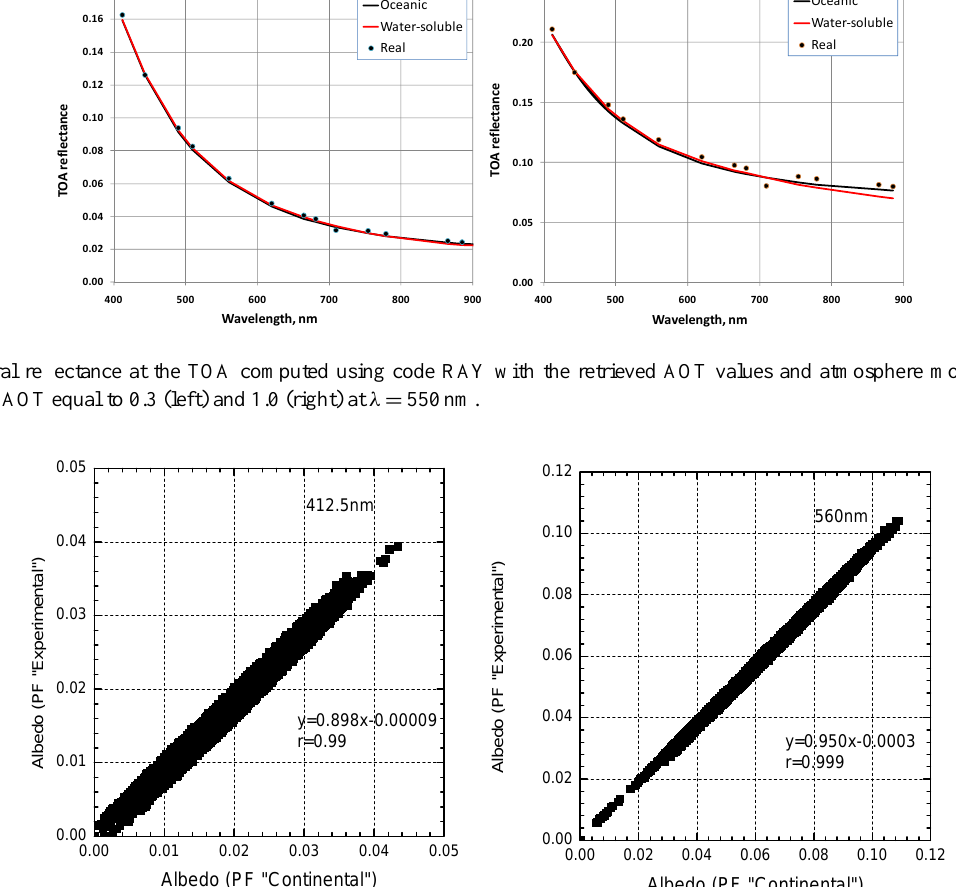
inequality immediately discards pixels containing